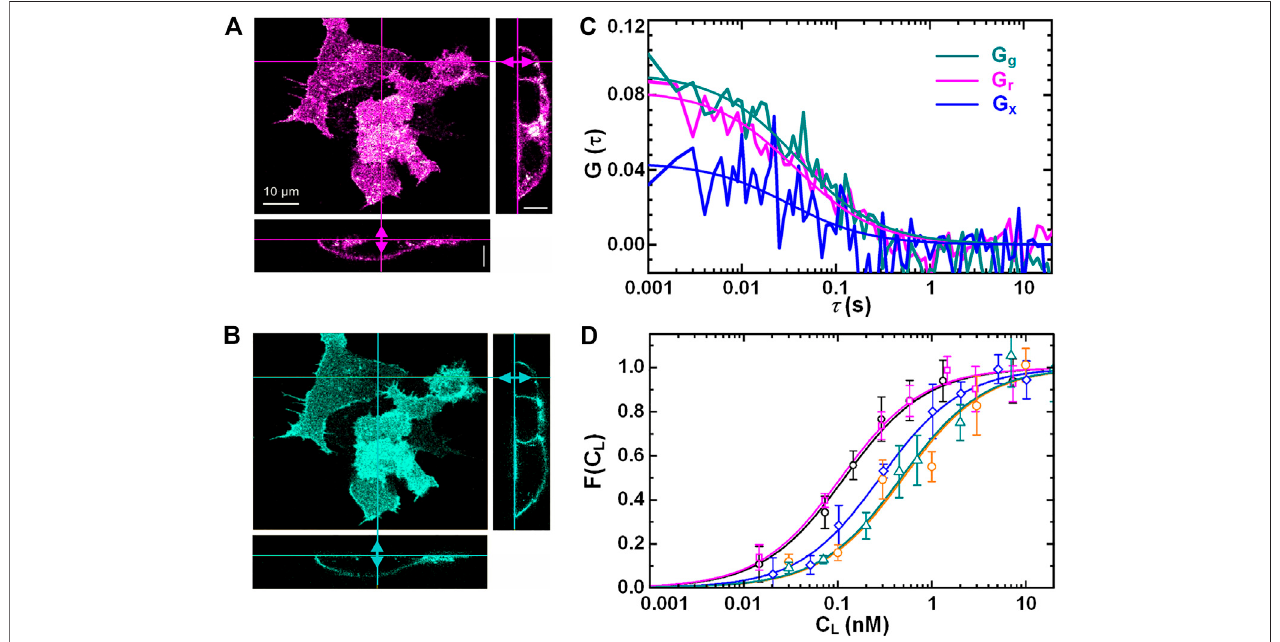
FIGURE 13 | Axial line-scanning FCS measurement on the interactions of ligand (DKK1-eGFP) and receptor (LRP6-mCherry) on cell membranes. Dual-color confocalimagesofliveHEK293 Tcellsintheredchannel( A )andthegreenchannel( B ).( C )Theautocorrelationcurves( G g and G r )andcross-correlationcurve( G x )onlive NCI-H1703 cells. ( D ) Five binding curves (Fractional occupancies of the receptors) of fi ve different cell-lines with different receptor densities. Adapted from Ref. [43].